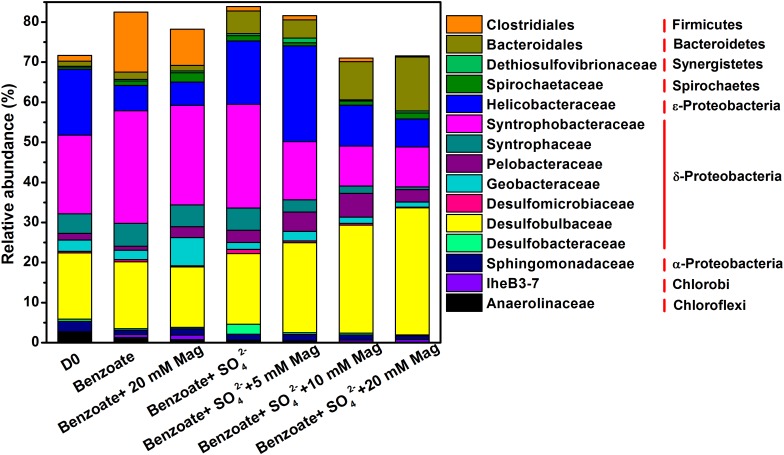
Taxonomic classification of 16S rRNA gene sequences from the extract DNA from anaerobic incubation of sulfate-dependent benzoate degradation in the presence and absence of magnetite, the sulfate-free control incubations and microbial inocula at the family level with a relative abundance greater than 1%. Mag denotes magnetite.